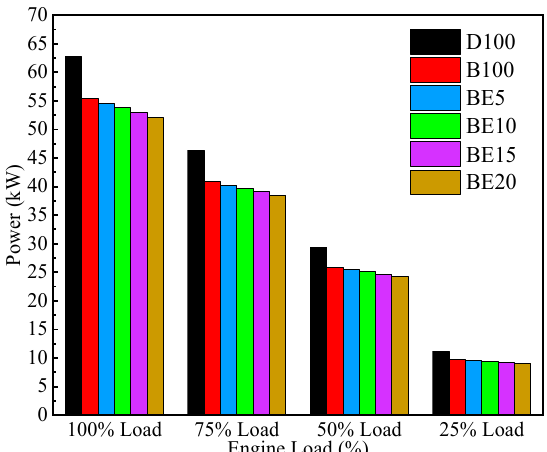
Figure 8. Comparisons of brake power for different fuels at different loads.